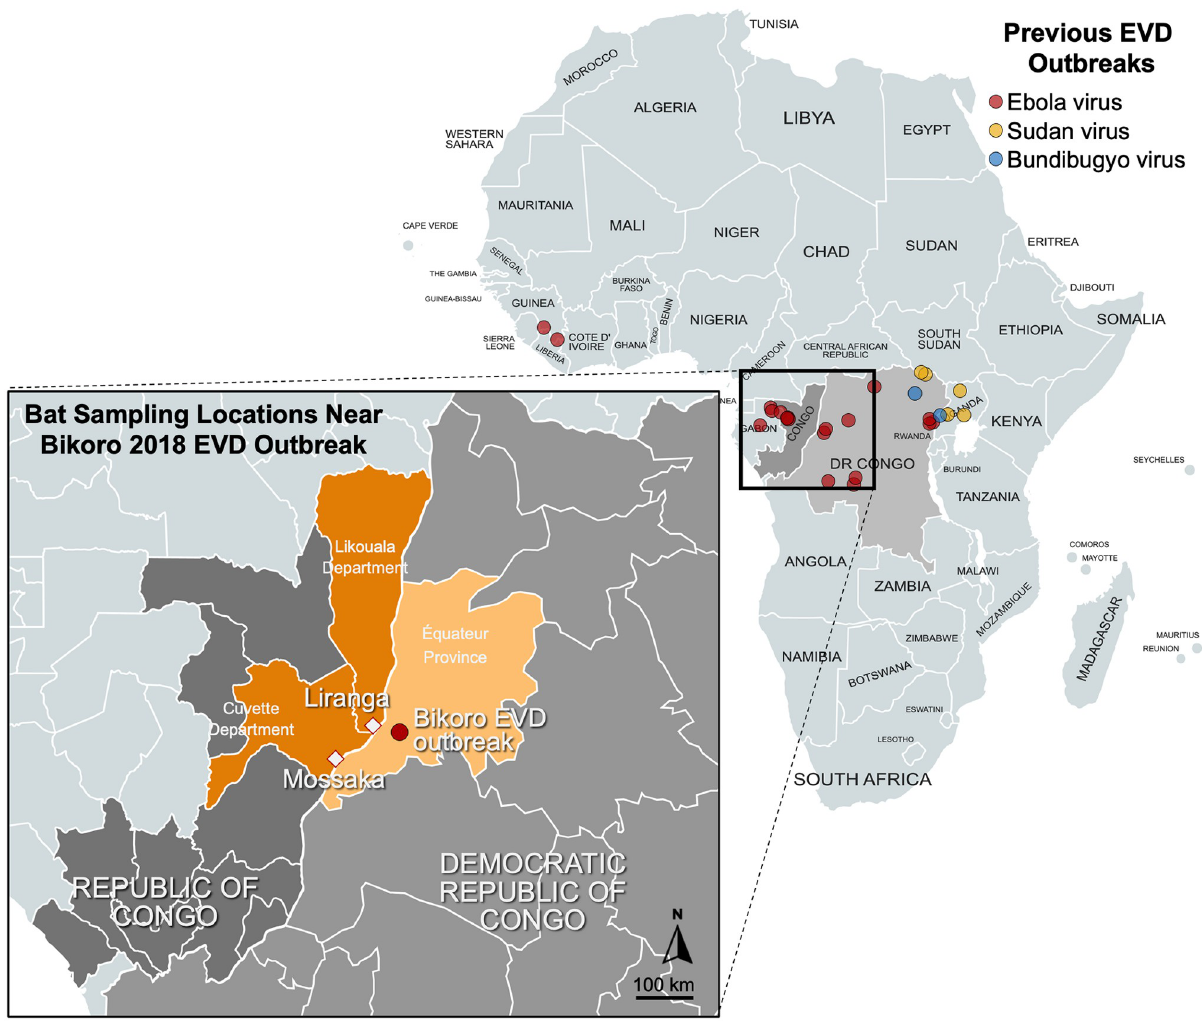
Fig 1. Locations of historical Ebola virus disease outbreaks in Africa associated with Zaire ebolavirus (Ebola virus, red), Sudan virus (yellow), or Bundibugyo virus (blue). Inset map shows the sampling locations in Mossaka and Liranga, Republic of Congo, relative to the 2018 Ebola virus disease outbreak in Bikoro, Democratic Republic of Congo. A total of 31 bats were sampled at the Liranga field sites and 165 bats were sampled at the Mossaka field site. Base layer map data sourced through Natural Earth http://www.naturalearthdata.com/.